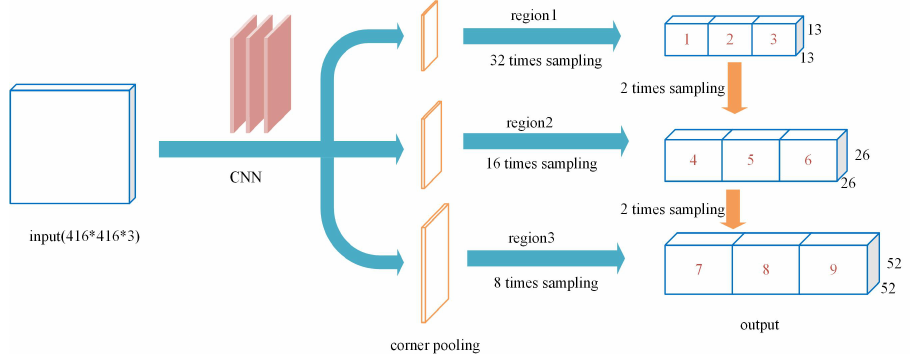
Figure 5. The architecture of the network.